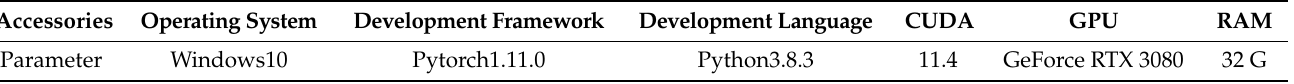
Table 2. Experimental environment configuration.